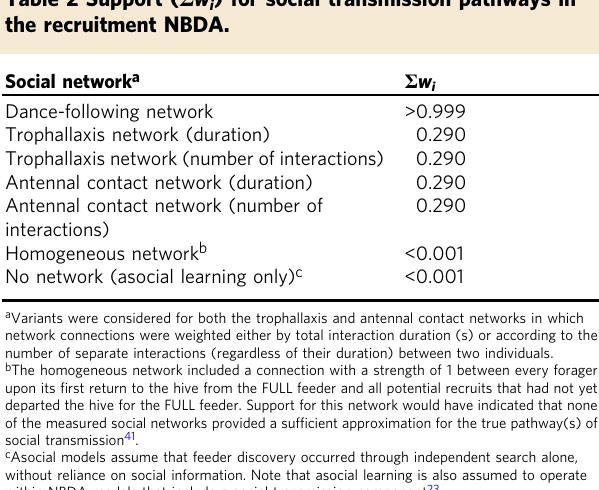
Table 2 Support ( Σ w i ) for social transmission pathways